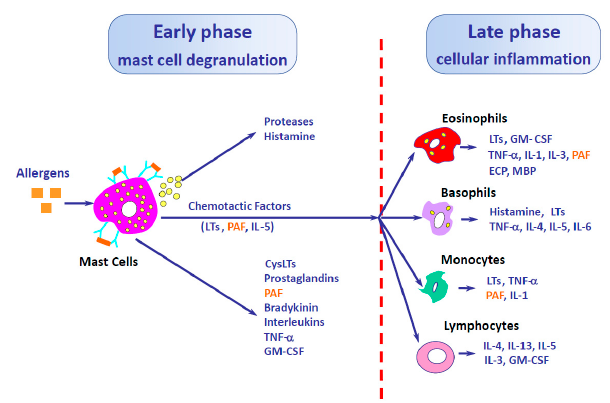
Figure 1. Importance of platelet-activating factor (PAF) in the early and late phases of allergic response. Adapted from [4] with permission.